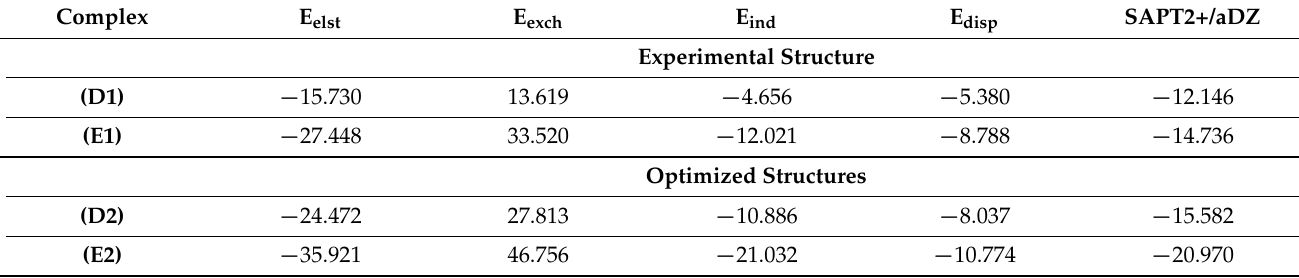
Table 3. Interaction energies between the examined dimers taken from the experimental structure [51] and after relaxation at the ω B97XD/def2TZVP level of theory. The calculations were performed at the SAPT2+/aug-cc-pVDZ level of theory, and the energies are given in kcal * mol − 1